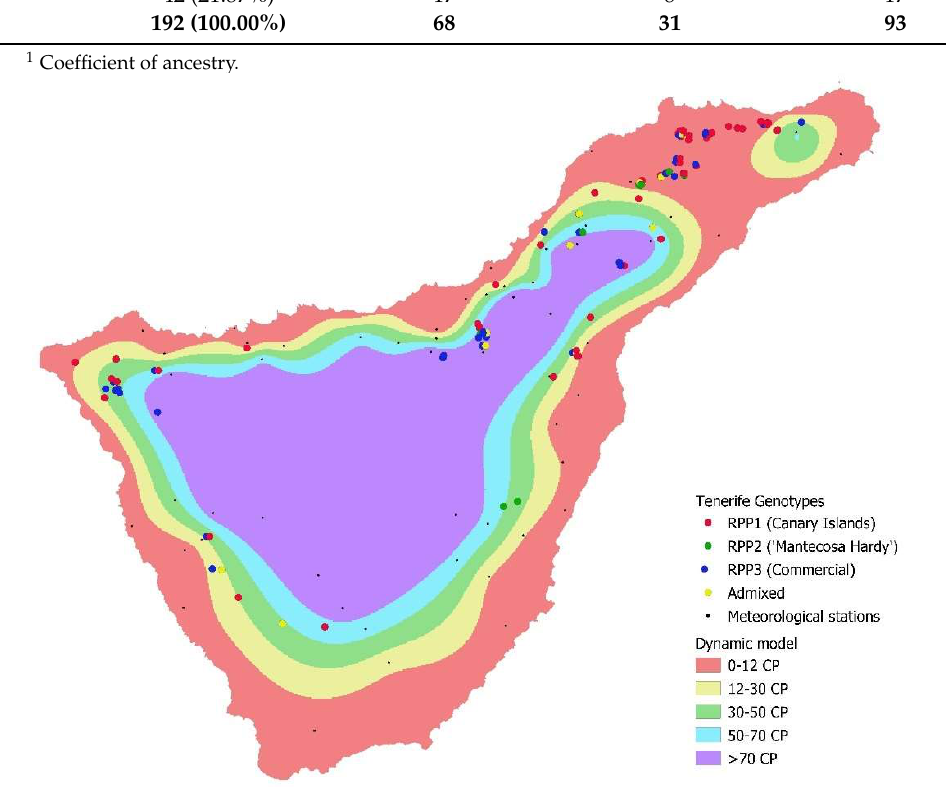
Figure 2. Tenerife genotypes, classified in RPP1-3 and admixed, and their sampling locations in Tenerife, according to the chill portions (CP) of the dynamic model (Fishman et al., 1987) [20]. Table 3. Classification of 192 diploid pear genotypes for K = 3 and K = 4 reconstructed populations (RPPs) according to STRUCTURE [35] for the total study sample.